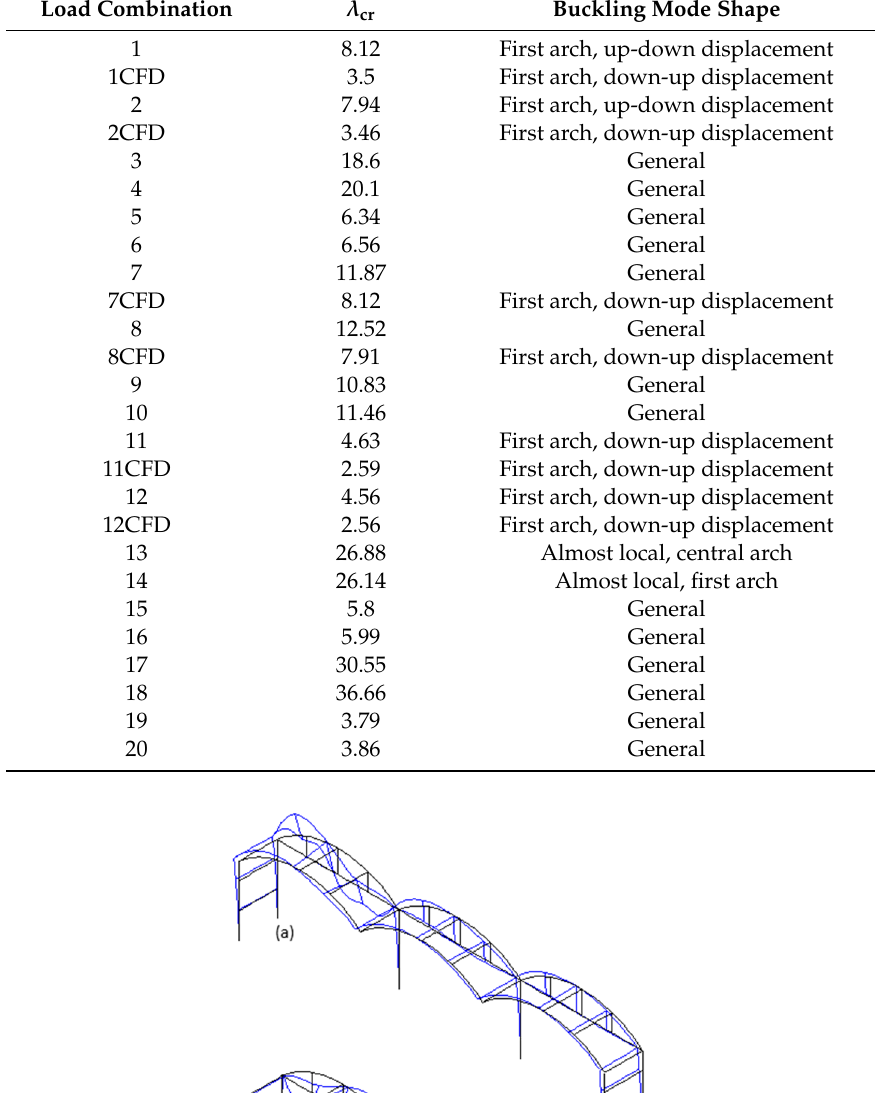
Table 4. λ cr values for the di ff erent combinations considered.